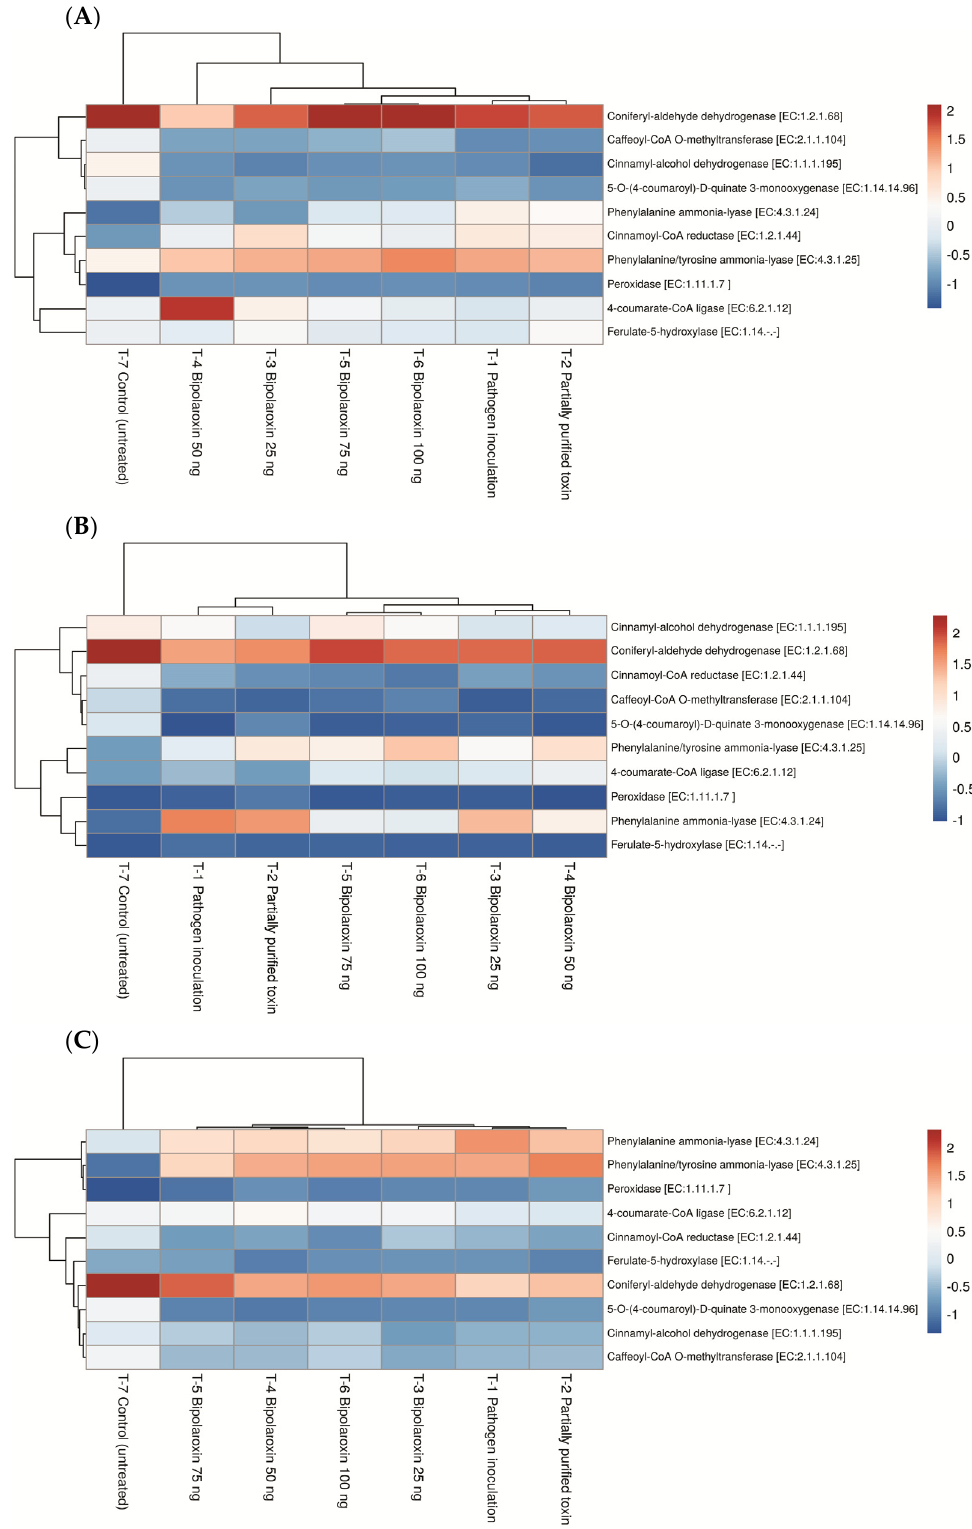
Figure 11. Expression profile of key genes of phenylpropanoid pathways in susceptible line, Agra Local ( A ) and resistant lines, Chinese Spring ( B ), and Chirya3 ( C ) under pathogen inoculation and infiltration of partially purified toxin obtained from B. sorokiniana as well as chemically synthesized Bipolaroxin at 7 days of inoculation/treatments under glasshouse conditions.